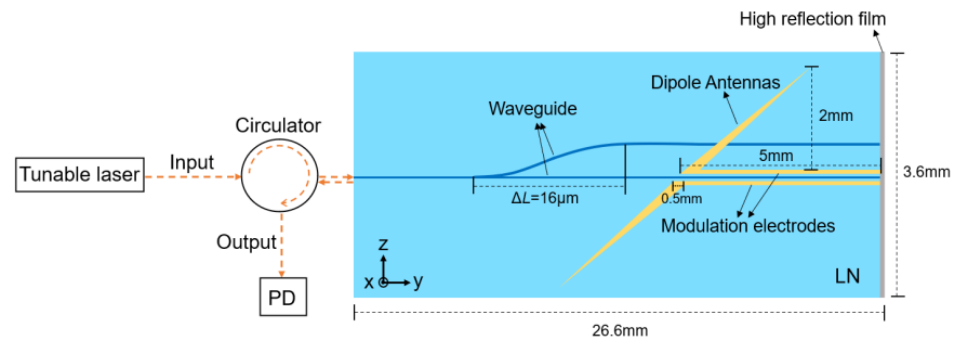
Figure 1. Diagrammatic drawing of the EFS based on LNOI for a single polarization